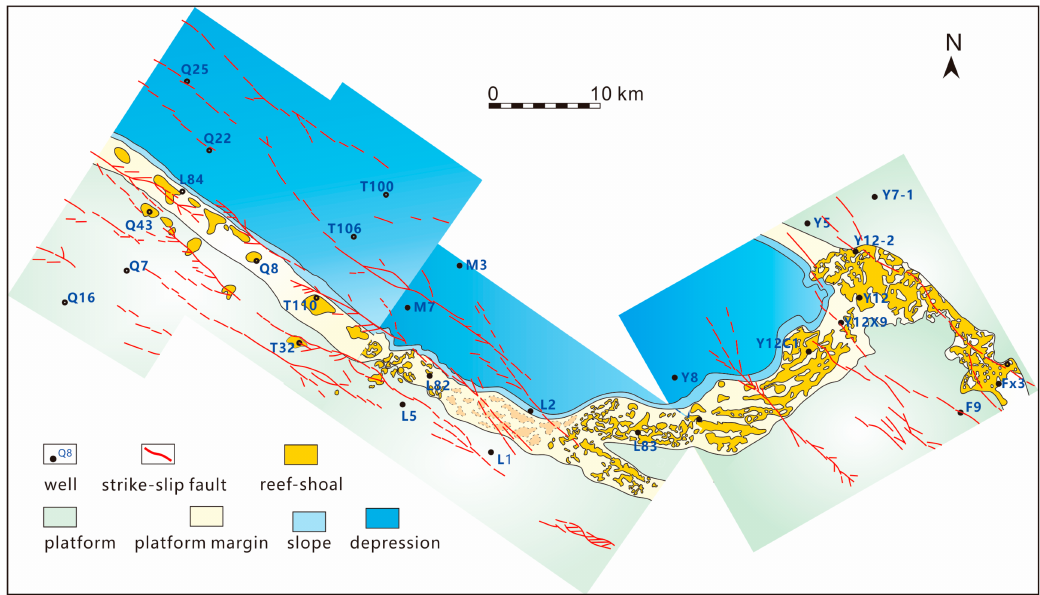
Figure 2. The strike-slip faults overlapping with the reef–shoal bodies in the Changxing Formation in eastern Kaijiang-Liangping